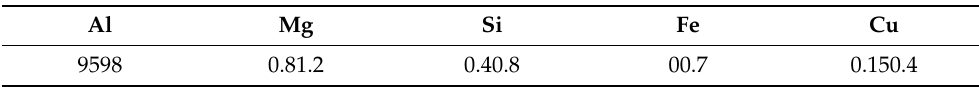
Table 3. Chemical composition of 6061 aluminum alloy